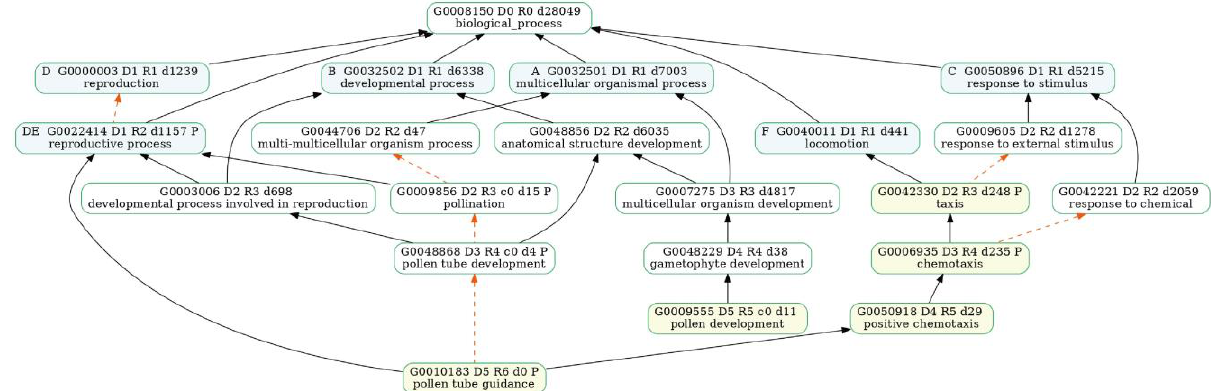
Figure 9. GOATOOLS [40] analysis of the association map of GO biological processes enriched in the second stage of male flower buds. Hierarchical relationships show that GO terms enriched in the results (yellow) can be associated with reproductive processes (blue).